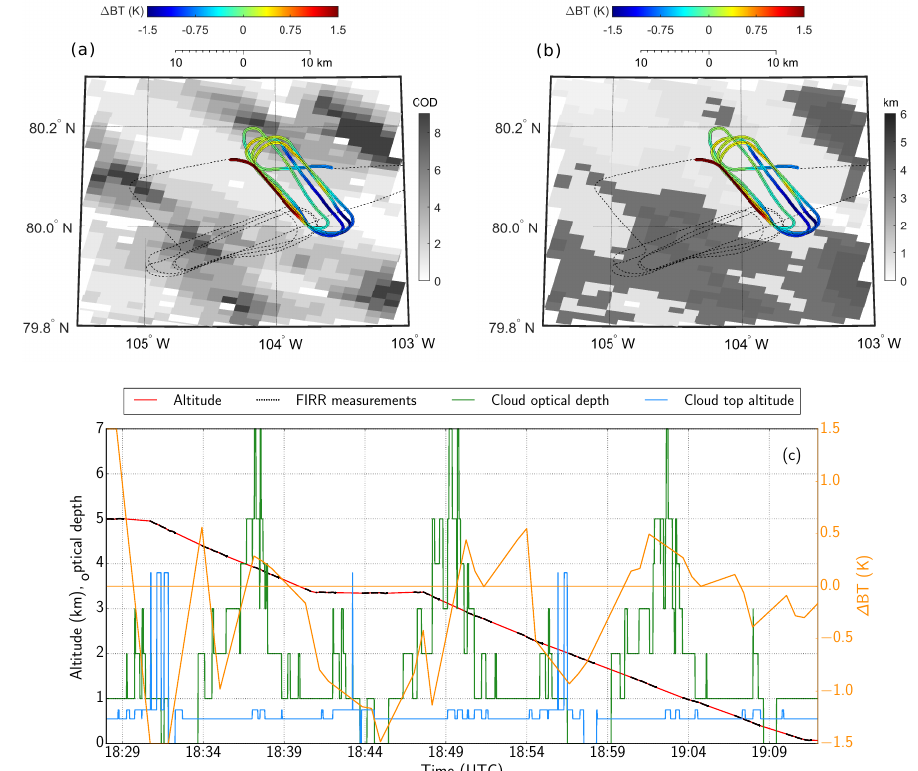
Figure 13. (a) Optical depth at 1.24µm and (b) cloud top altitude derived from MODIS observations at the beginning of the profile on 13 April (18:09UTC). Polar 6 trajectory is highlighted, with the colour corresponding to the difference between measured and simulated ( τ = 2) brightness temperatures for the 10–12µm channel. Blue suggests the actual optical depth is larger than 2 while red suggests it is less. (c) Difference between measured and simulated ( τ = 2) brightness temperatures for the 10–12µm channel as a function of time, along with flight altitude and MODIS estimates of cloud optical depth and cloud top altitude. Black dots indicate when FIRR spectral measurements are actually